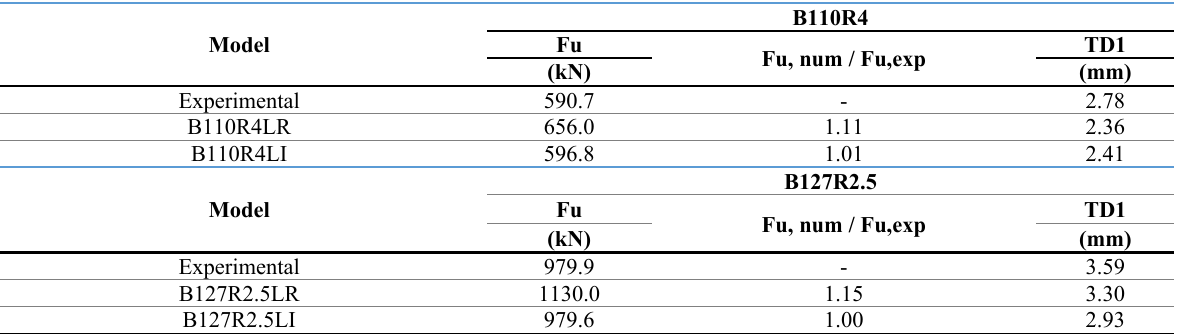
Table 4. Results for failure loads and displacement in transducers of the experimental and numerical models with variation in pile cap/pile